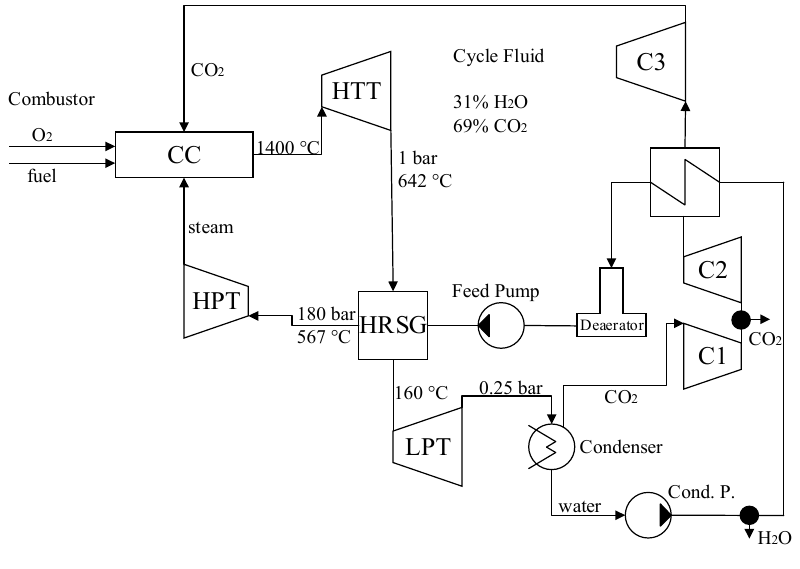
Figure 9. Flow diagram of the Graz basic cycle.